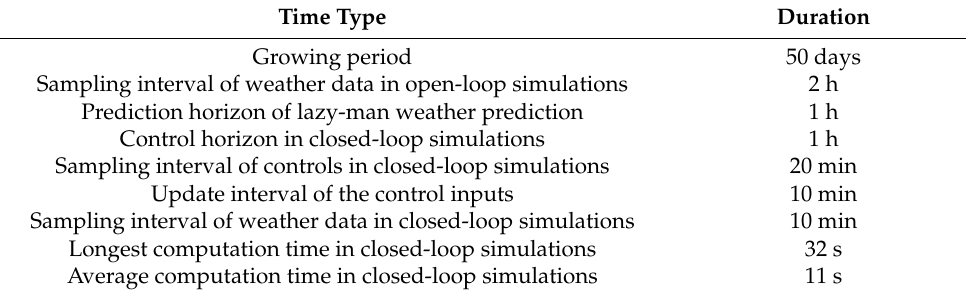
Table 5. Different durations of time. Time Type Duration Growing period 50 days Sampling interval of weather data in open-loop simulations 2 h Prediction horizon of lazy-man weather prediction 1 h Control horizon in closed-loop simulations Sampling interval of controls in closed-loop simulations 20 min Update interval of the control inputs Sampling interval of weather data in closed-loop simulations 10 min Longest computation time in closed-loop simulations 32 s Average computation time in closed-loop